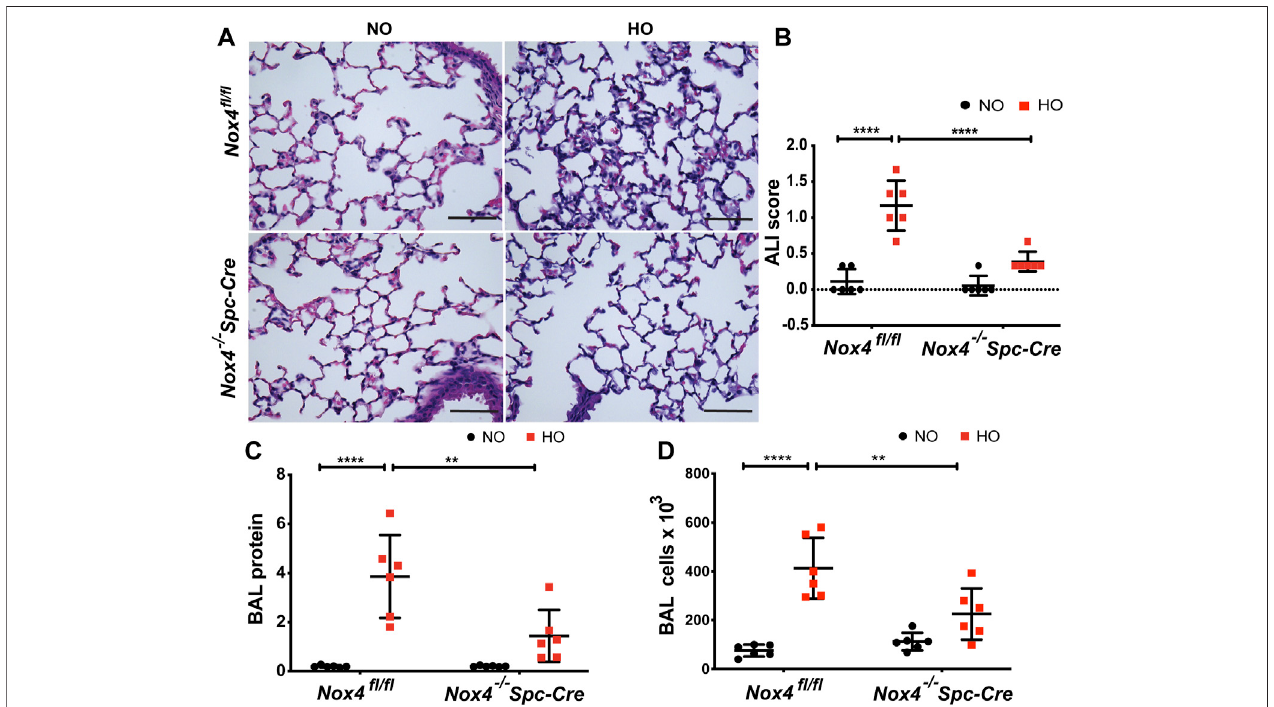
FIGURE 3 | Genetic Deletion of Nox4 in AT2 cells of mice reduced HALI. Nox4 fl / fl control mice and Nox4 − / − Spc-Cre mice induced with tamoxifen and were subjected to NO or HO for 66 h. (A) Representative H&E photomicrographs of lung tissue sections from Nox4 fl / fl and Nox4 − / − Spc-Cre mice exposed to NO or HO. Quantitative data of (B) ALI scores based on the in fi ltrating neutrophils, alveolar wall thickening and proteinaceous debris deposition (C) BAL protein and (D) cell counts were elevated in HO exposed control mice and were attenuated by epithelial deletion of Nox4 . Scale bar = 100 µm. n = 6. **** p < 0.0001, *** p < 0.001, ** p < 0.01 and * p <